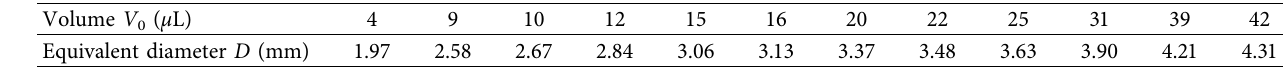
Table 4: Volume calibration table for